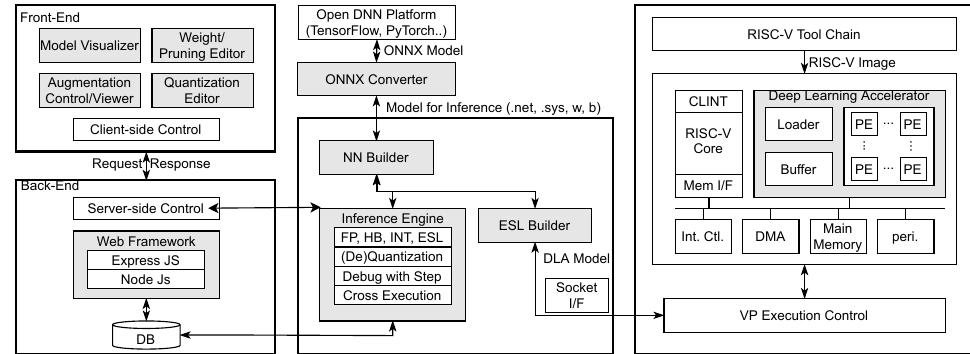
Figure 1. The overall architecture of the